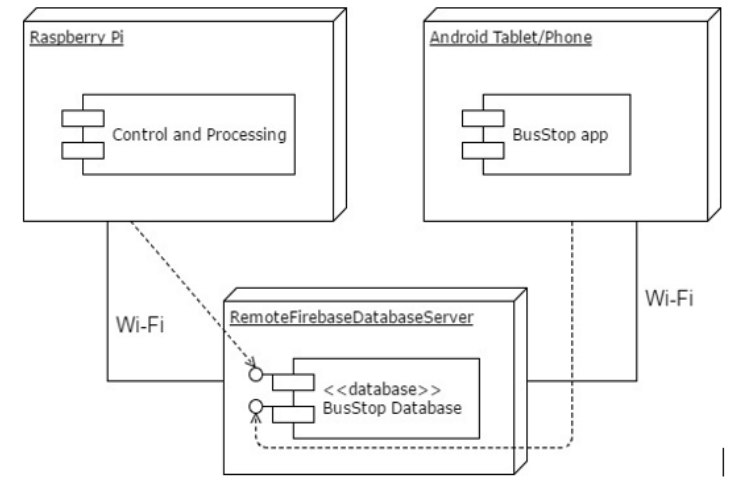
Figure 3. System deployment diagram.